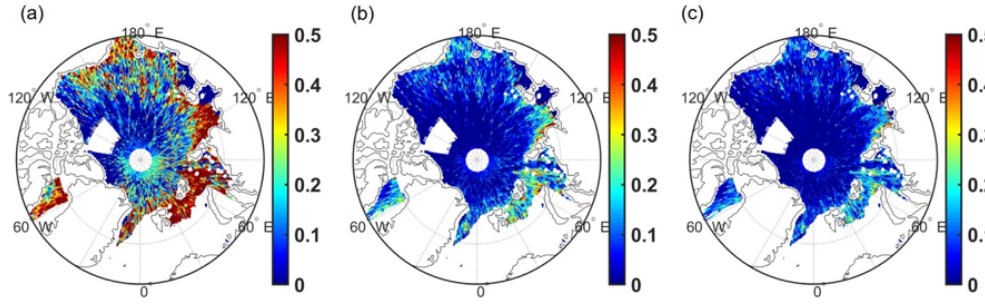
Figure 13. Monthly lead fraction maps based on Tilling et al. (2018) (a) and stack peakiness 13 (b) and 15 (c) in April 2011.